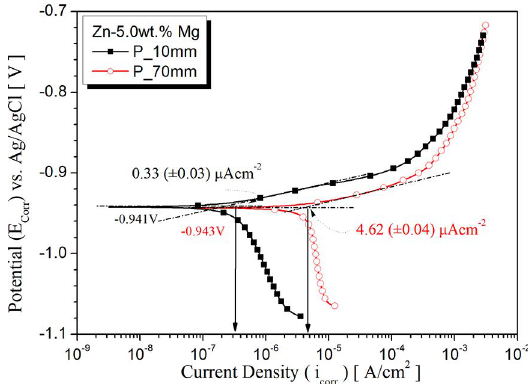
Figure 10. Potentiodynamic polarization curves of the Zn-5.0wt.%Mg alloy for samples of positions P_10mm and P_70mm. Table 3. Polarization parameters for samples (P_10mm) and (P_70mm) of the Zn-5.0wt.%Mg alloy